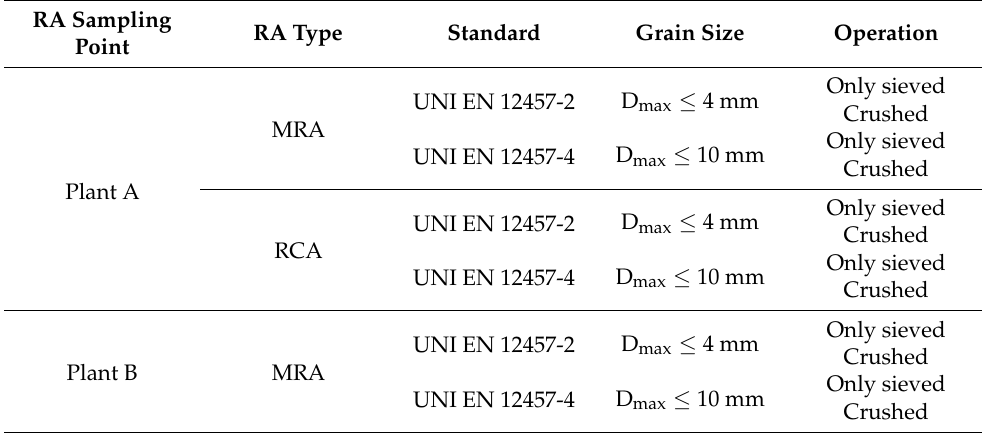
Table 3. Battery of RA samples. RA